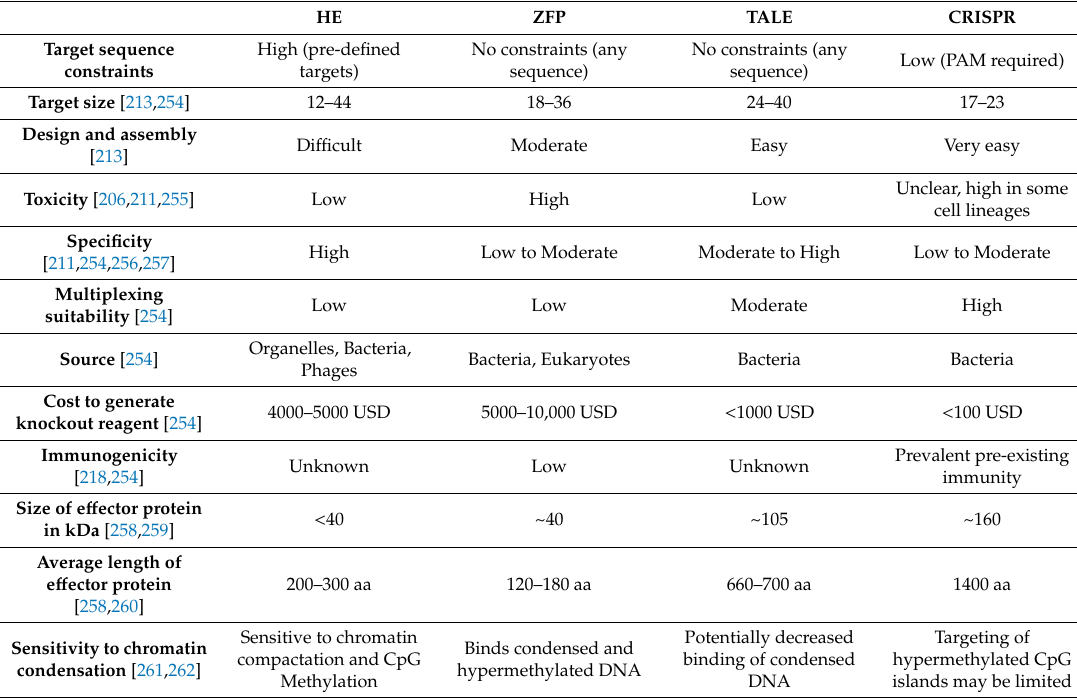
Table 1. Properties of common gene editing